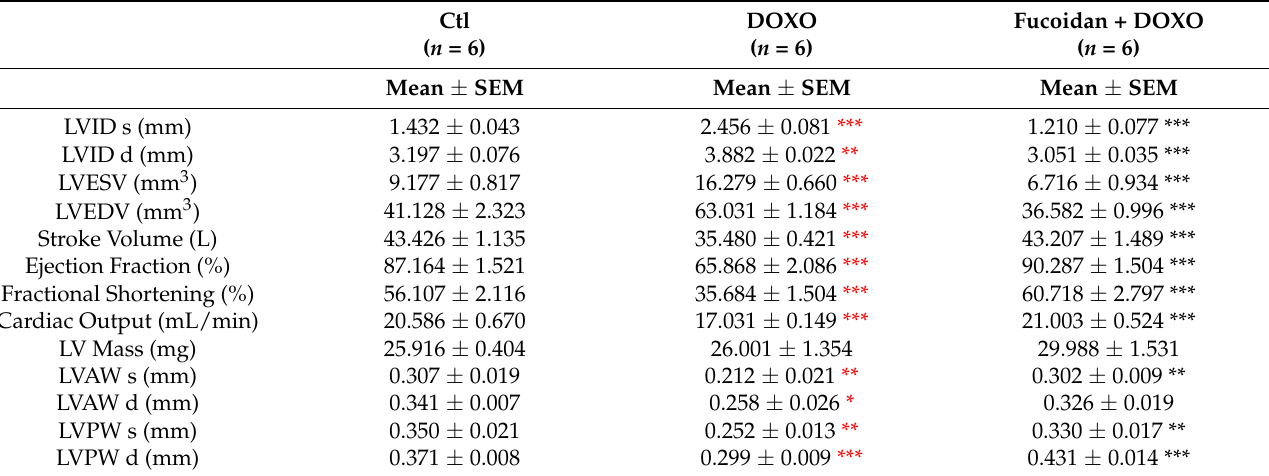
M-model short-axis echocardiographic image showing left ventricular dilation caused by DOXO and the protective effect of fucoidan in the mice of the fucoidan + DOXO group. ( C ) Left ventricular systole/diastole diameter (LVTDs/LVTDd) and left ventricular end-systolic/end-diastolic volume (LVESv/LVEDv) were significantly lower in fucoidan–DOXO-treated mice than in those in the DOXO group, and on the contrary, stroke volume (SV), cardiac output (CO), ejection fraction (EF) and left ventricular fractional shortening (LVFS) were significantly higher. ** p < 0.01; *** p < 0.001. The red asterisk is used to indicate the difference between the DOXO group and the Ctl group, and the black asterisk is used to indicate the difference between the DOXO group and the Fucoidan + DOXO group. Table 1. Comparison of cardiac parameters between three treatments.